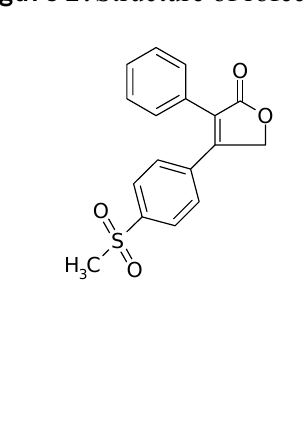
Figure 2. Structure of